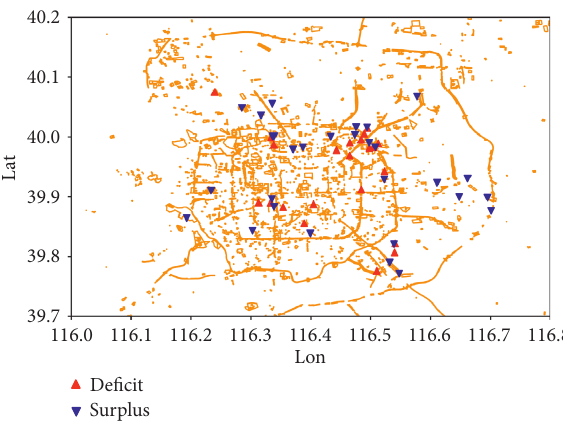
Figure 7: Spatial distribution of unbalance stations.